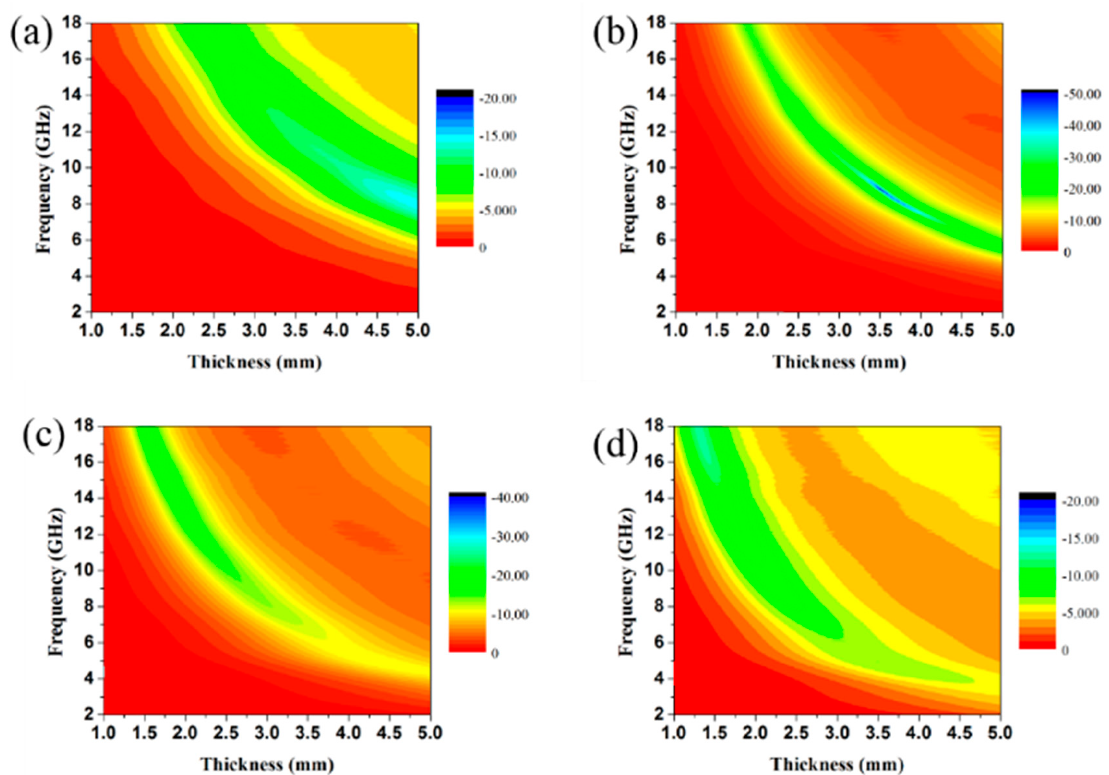
Figure 7. RL contour maps of paraffin composites containing 5 wt.% ( a ), 10 wt.% ( b ), 15 wt.% ( c ), and 20 wt.% ( d ) of rGO/CuS/PPy.